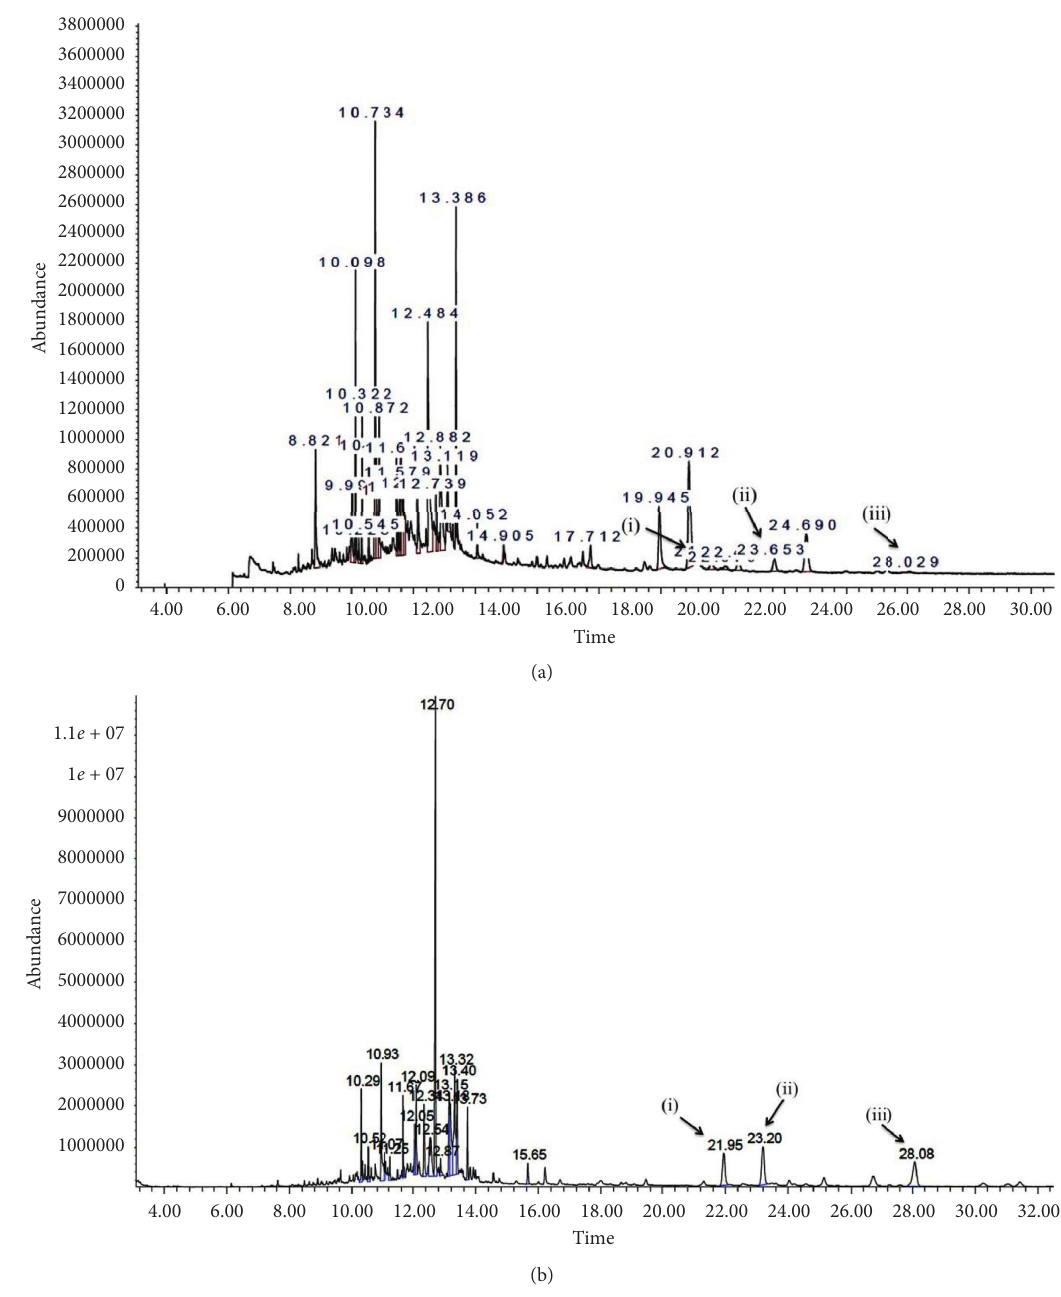
Figure 6: (a) and (b) Mass spectrogram of ETH extract and EHX fraction, respectively. (i) Stigmasterol. (ii) ß -Sitosterol. (iii) 3-O-